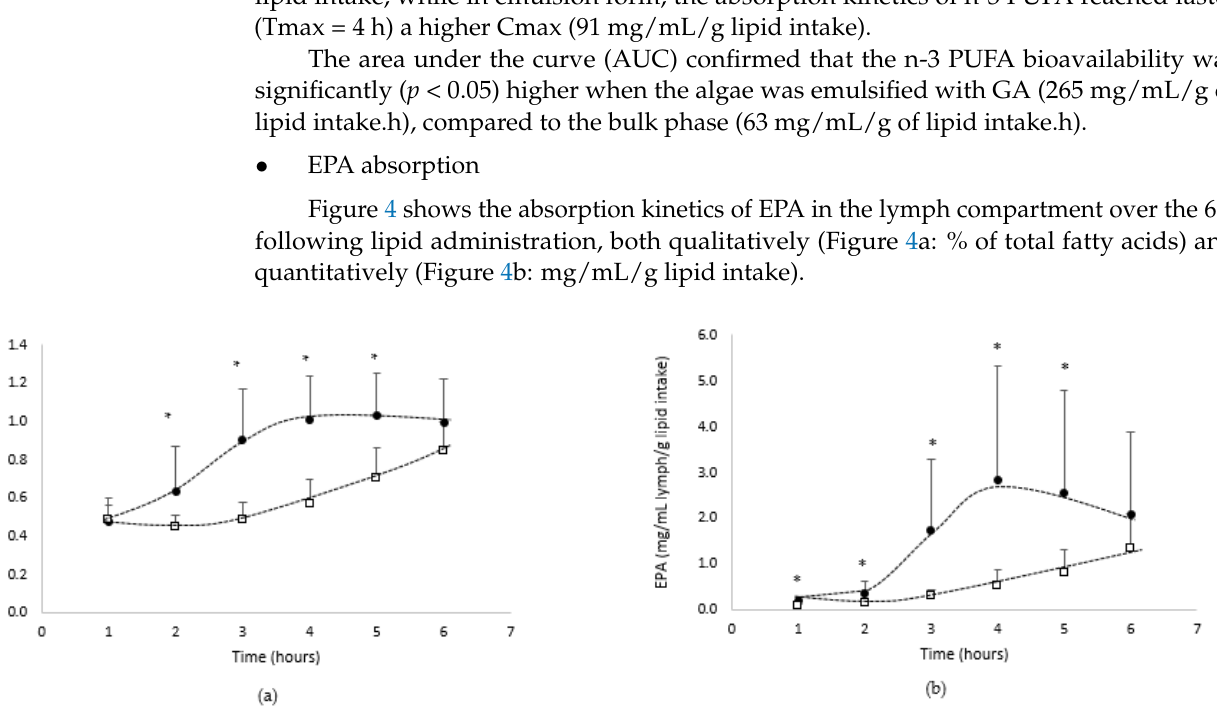
Figure 4. Kinetics of intestinal absorption of EPA (( a ): % of total fatty acids and ( b ): mg/mL lymph/g of lipid intake), in rats submitted to a lymphatic duct’s fistula ( n = 8 rats/group) and orally supplied with 200 mg of lipids from an oil either in bulk phase ( (cid:3) ) or emulsified with gum acacia ( • ) over a 6 h period. Data are presented as their means ± standard deviation *. For the same time period, data are significantly different between the two groups ( p < 0.05; Student’s t -test).